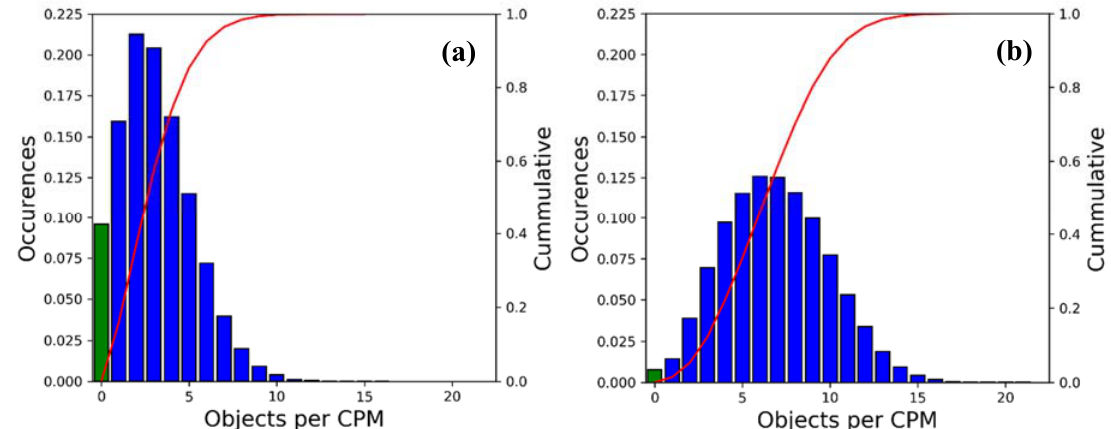
Figure 8. Probability Density Function (PDF; blue bars) and Cumulative Distribution Function (CDF; red line) of the number of objects per CPM for ( a ) the low traffic scenario and ( b ) the high traffic scenario. Not transmitted CPMs are depicted by green